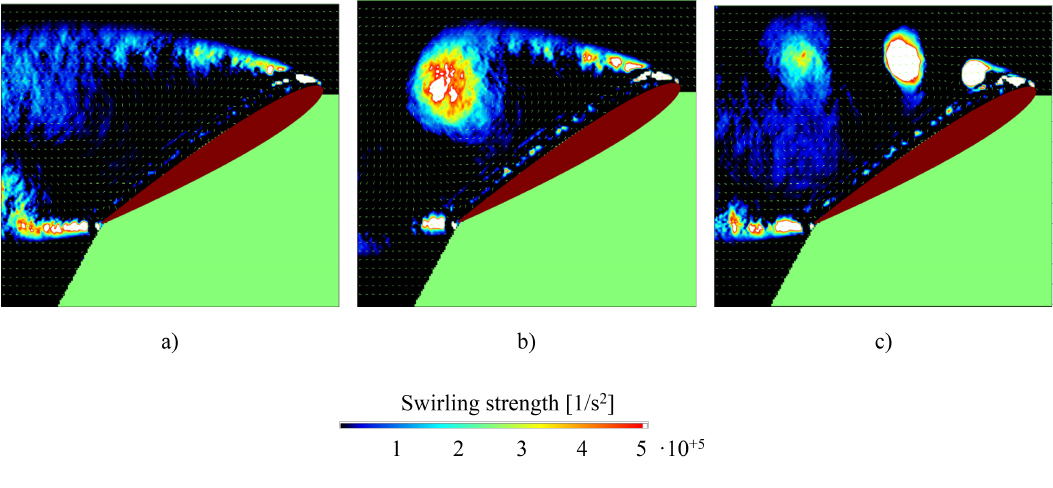
Figure 27. Swirling strengths at Re = 200,000 and α = 24 ◦ : with no actuation ( a ); at actuation frequency of 69Hz, ( b ); and at actuation frequency of 266.6Hz, ( c